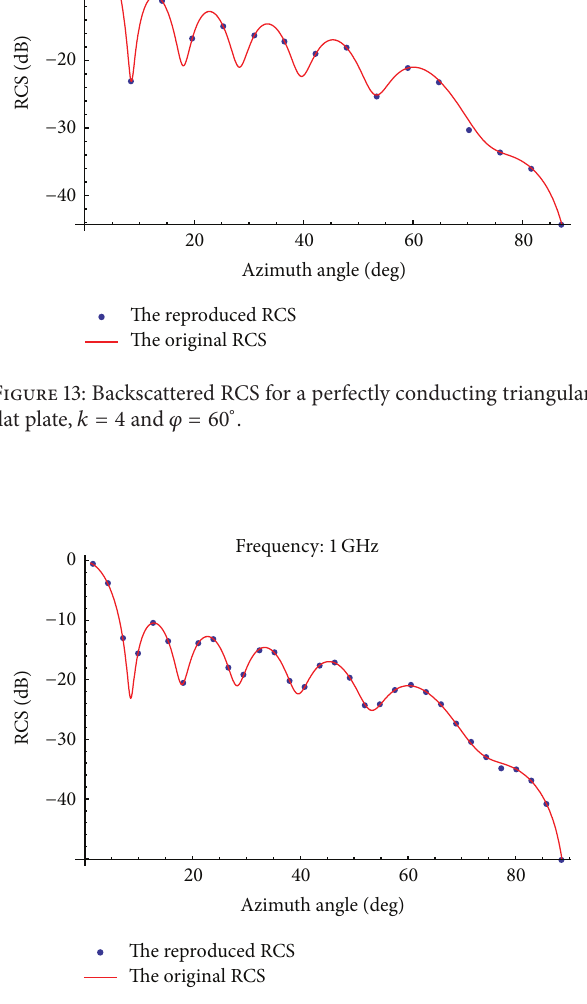
Figure 14: Backscattered RCS for a perfectly conducting triangular flat plate, 𝑘 = 5 and 𝜑 = 60 ∘ .